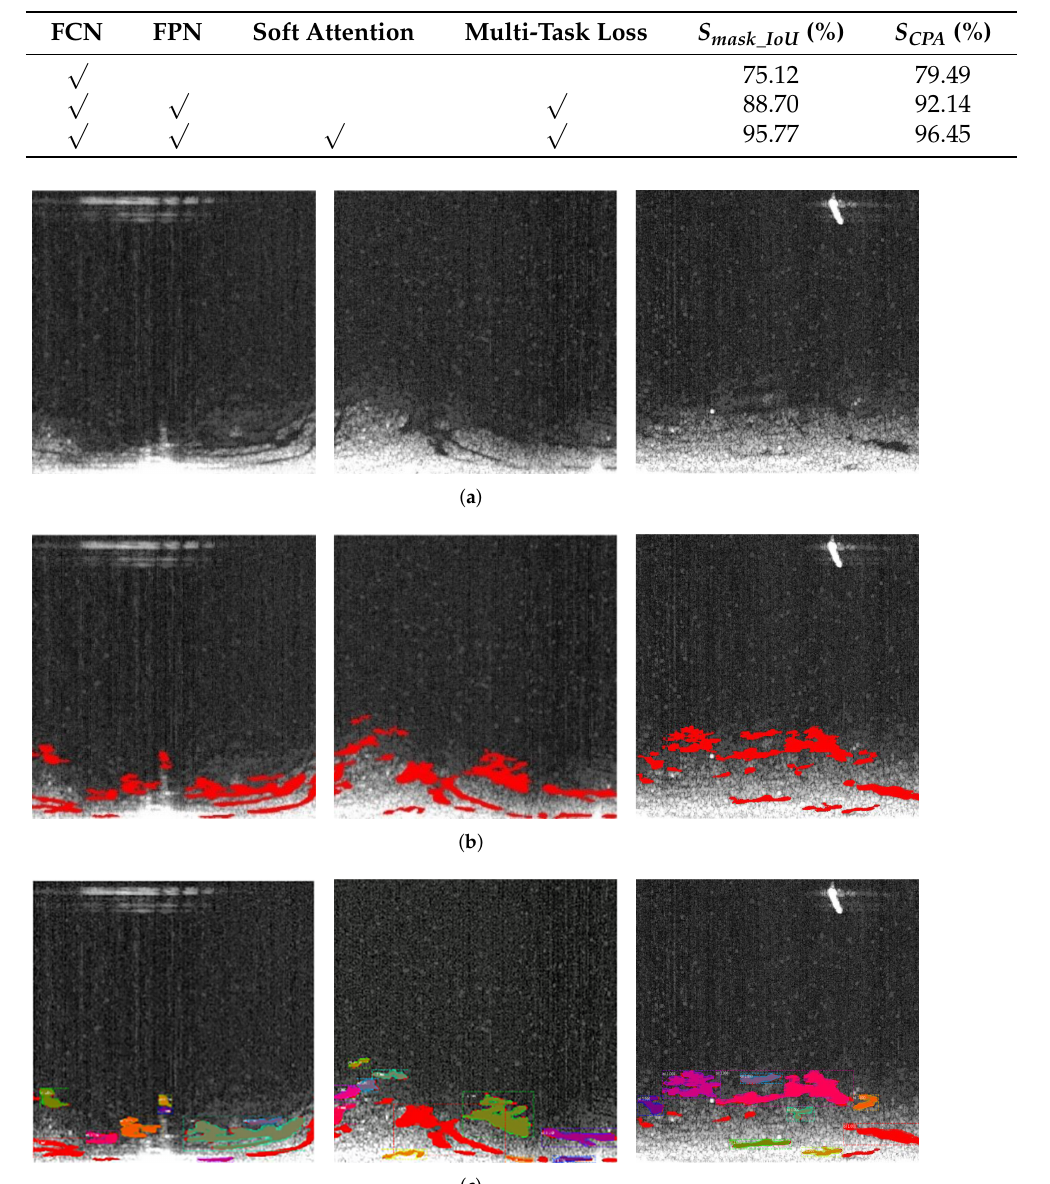
Table 2. Comparison of optimization after introducing different improvement modules.